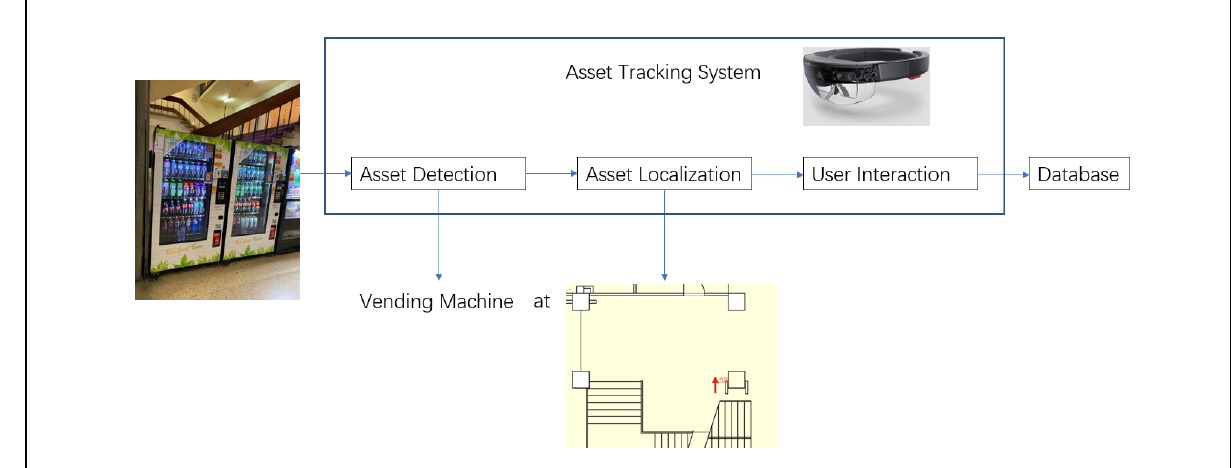
Figure 1 . Conceptual framework of the vending machine asset tracking